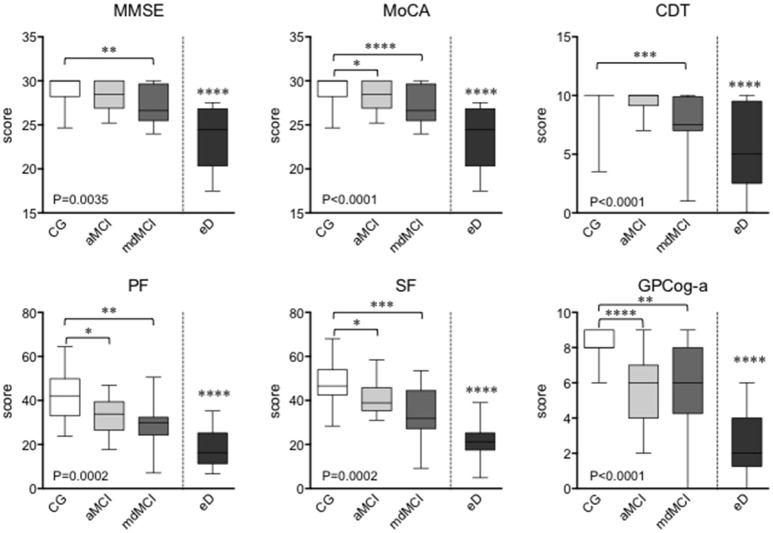
Results of the conventional neuropsycological test performed at the enrolment of the study. The graphs report median and interquartile range. The statistical analysis was performed by the non-parametric Kruskal-Wallis test with Dunn's multiple comparison having CG as control, where *p < 0.05; **p < 0.01; ***p < 0.001; ****p < 0.0001. MMSE, Mini Mental State Examination; MoCA, Montreal Cognitive Assessment; CDT, Clock Drawing Test; GPCog-a, General Practitioner Assessment of Cognition; PF, Phonemic verbal fluency tests; SF, Semantic verbal fluency tests.